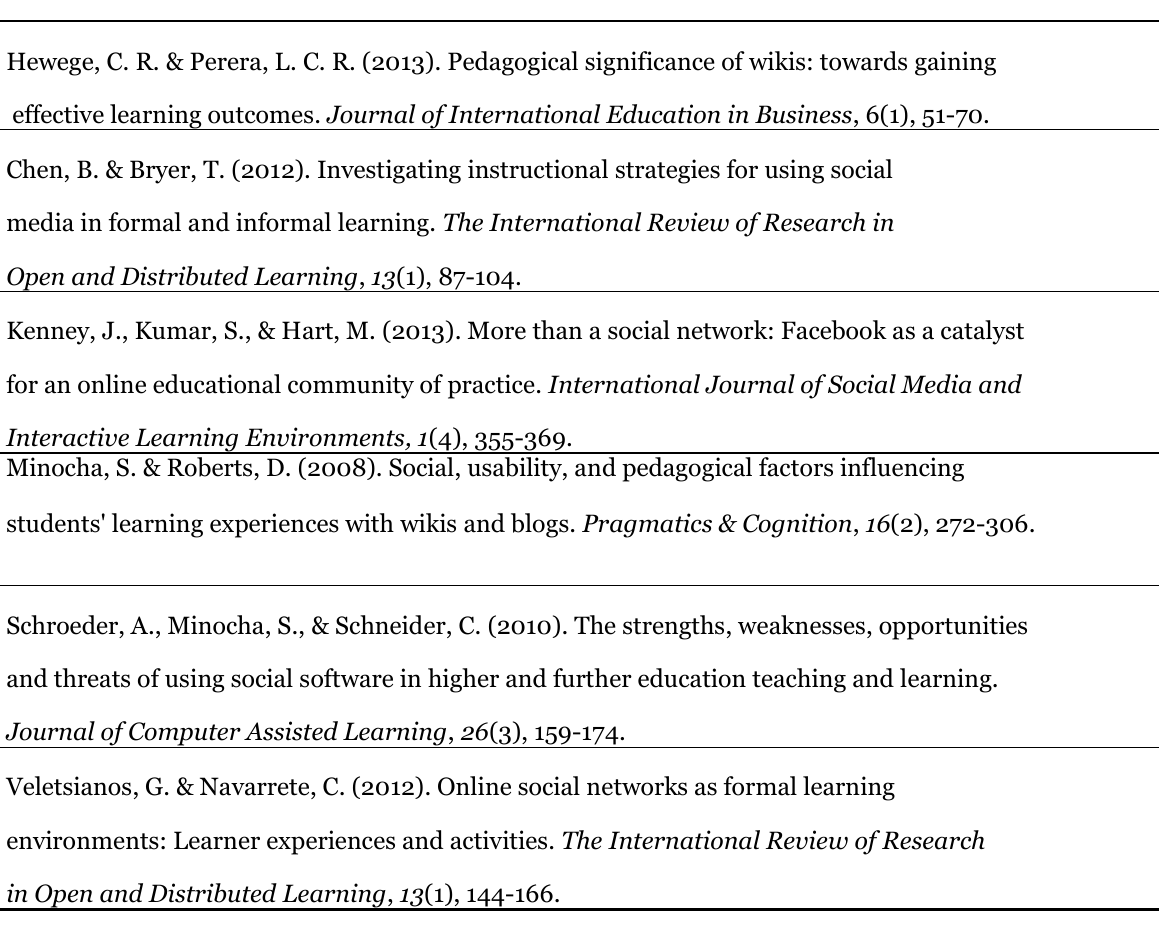
List of Articles Included in the